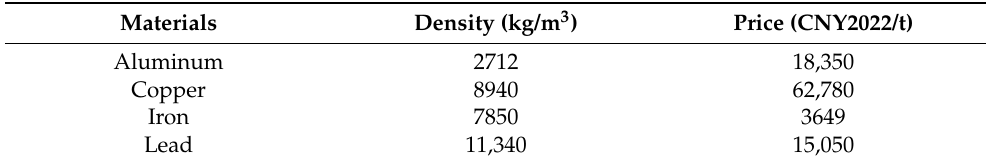
Table 4. Properties of common building materials.